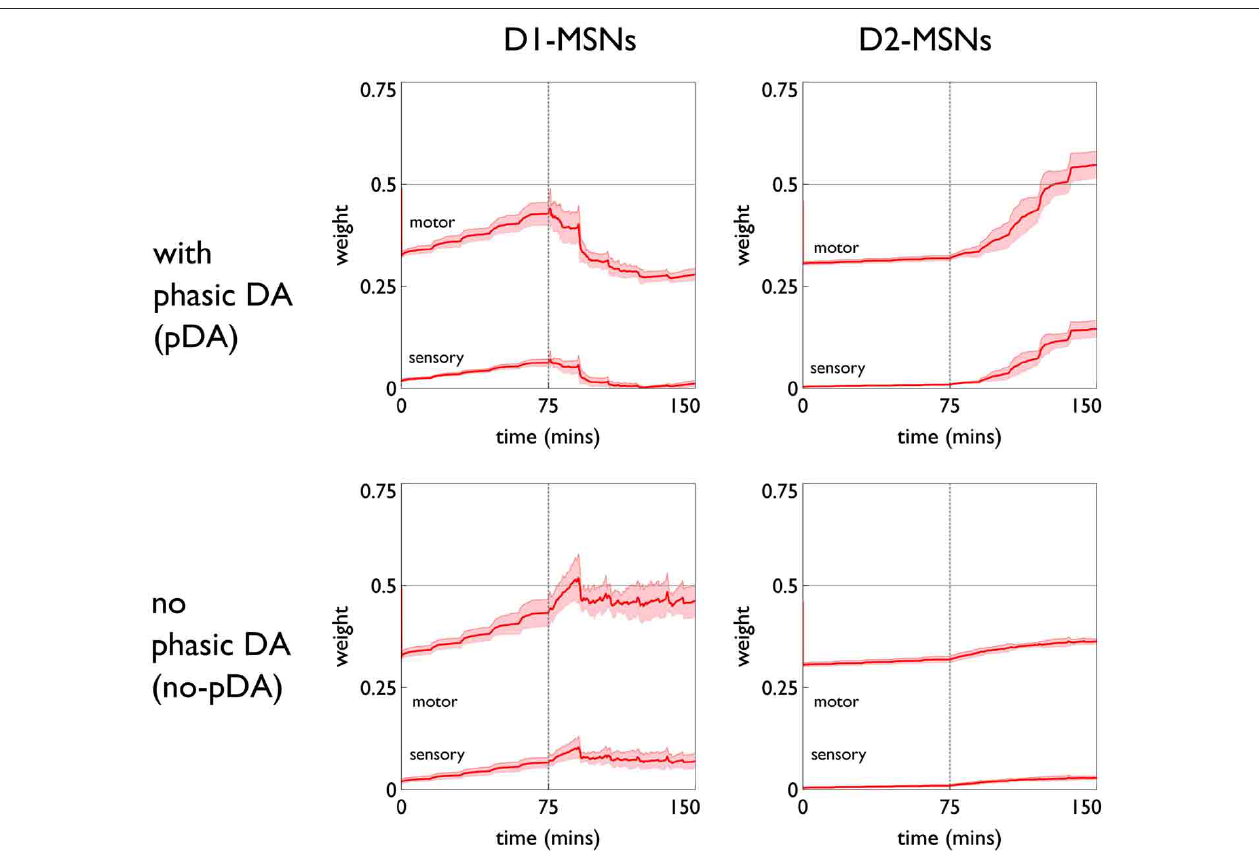
functions of time to show both within-day, and between-day dynamics, and the onset of the response contingent phase (at the start of day 6) is indicated at 75min. These plots capture the statistics of the weights over a group of 10 models; the dark red line is the mean, and the red-shaded region encompasses ± 1 std